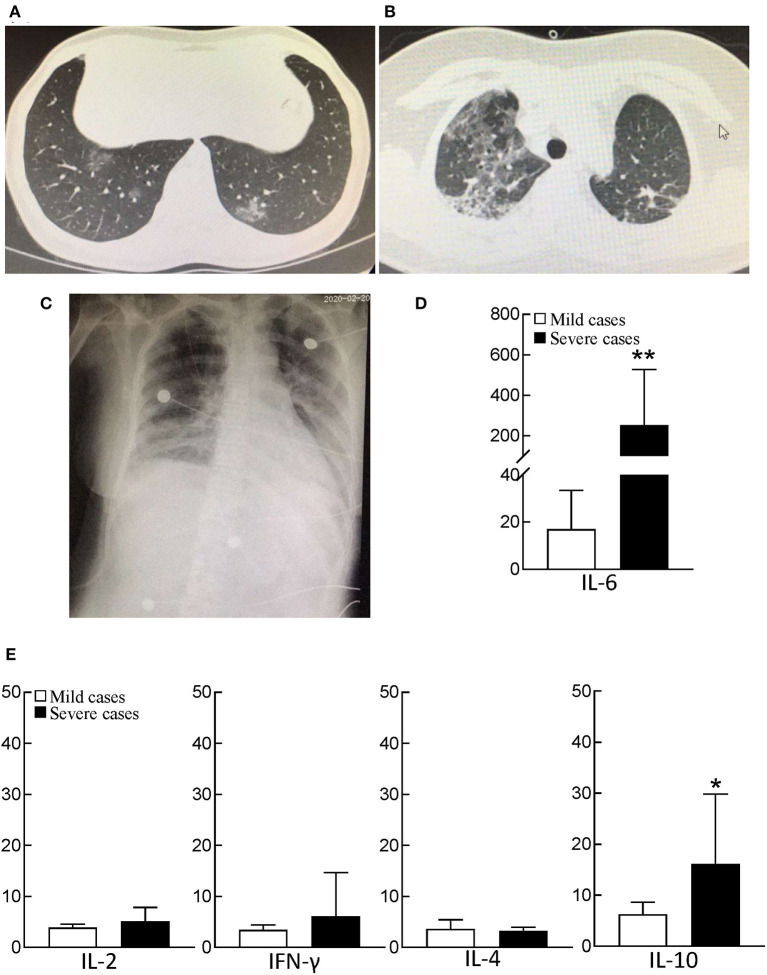
CT and bedside chest X-ray images and serum cytokine concentrations of patients with COVID-19. (A) Chest CT image of mild patient showed small patchy, ground glass opacity in the lower lobes of both lungs. (B) Chest CT image of severe patient showed critically diffusing, ground glass opacity in the lungs, especially in right lung. (C) The critically ill patient's bedside chest X-ray showed the lung texture enhanced and the translucency decreased, and multiple patchy shadows in both lungs. (D) serum IL-6 concentration between mild patients (n = 32) and severe patients (n = 21). The normal range of IL-6 is ≤10 pg/ml. **p < 0.01. (E) The analysis of Th1/Th2 cytokine panel between mild patients (n = 32) and severe patients (n = 21). The normal range of IL-2, IFN-γ, IL-4, and IL-10 are ≤11.4 pg/ml, 18 pg/ml, 12.9 pg/ml, and 5.9 pg/ml, respectively. *p < 0.05.